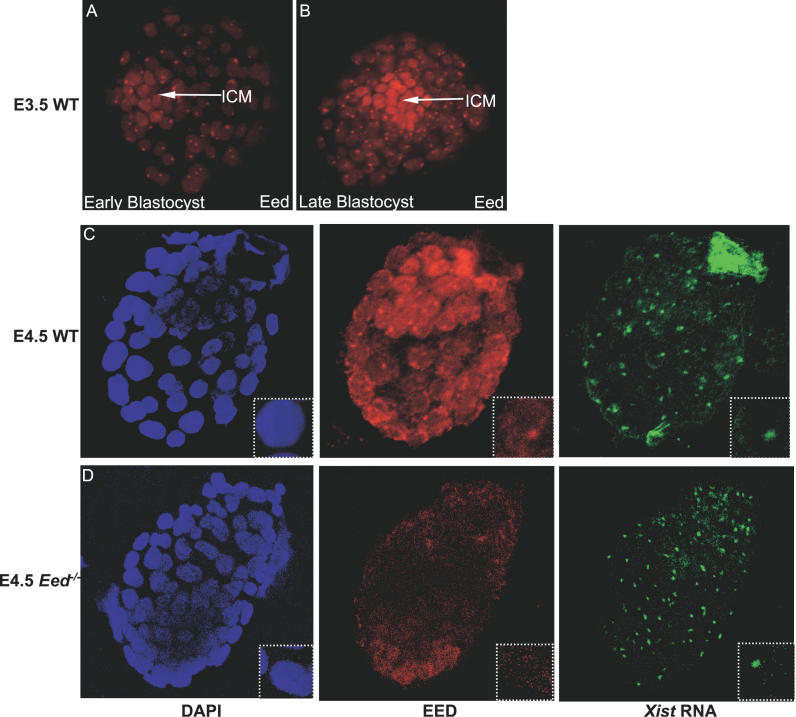
Absence of EED Protein in Eed
−/− Embryos at E4.5(A) IF detection of EED protein in an early E3.5 blastocyst stage embryo showing Xi enrichment of EED in all cells.(B) IF detection in a hatched, late-stage E3.5 blastocyst shows accumulation of EED on the Xi in trophoblast cells, an extraembryonic cell type that maintains imprinted XCI of the Xp but lacking Xi enrichment in ICM cells. The ICM cells at this stage of development undergo erasure of the imprint that ensures preferential transcriptional inactivation of the Xp.(C) IF detection of Xi-enriched EED protein in a WT E4.5 embryo. The Xi is coated with the Xist RNA, detected by FISH. DAPI staining detects nuclei.(D) IF-FISH staining of an E4.5 female embryo showing an absence of EED protein. The EED antibody staining seen is background and does not overlap with the Xi, as marked by Xist RNA coating.